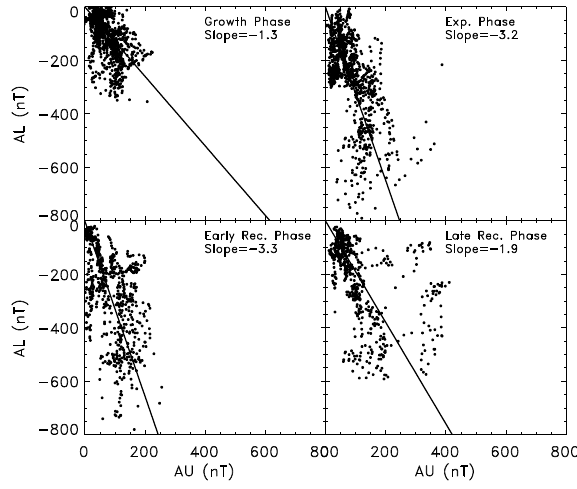
Fig. 8. AU shown as a function of AL for the 34 passes. Early and late recovery phases are defined by the eastward AL jump from onset region to dawn region. Linear fits are weighted by the number of points supplied by each event in order to avoid any bias toward single events.